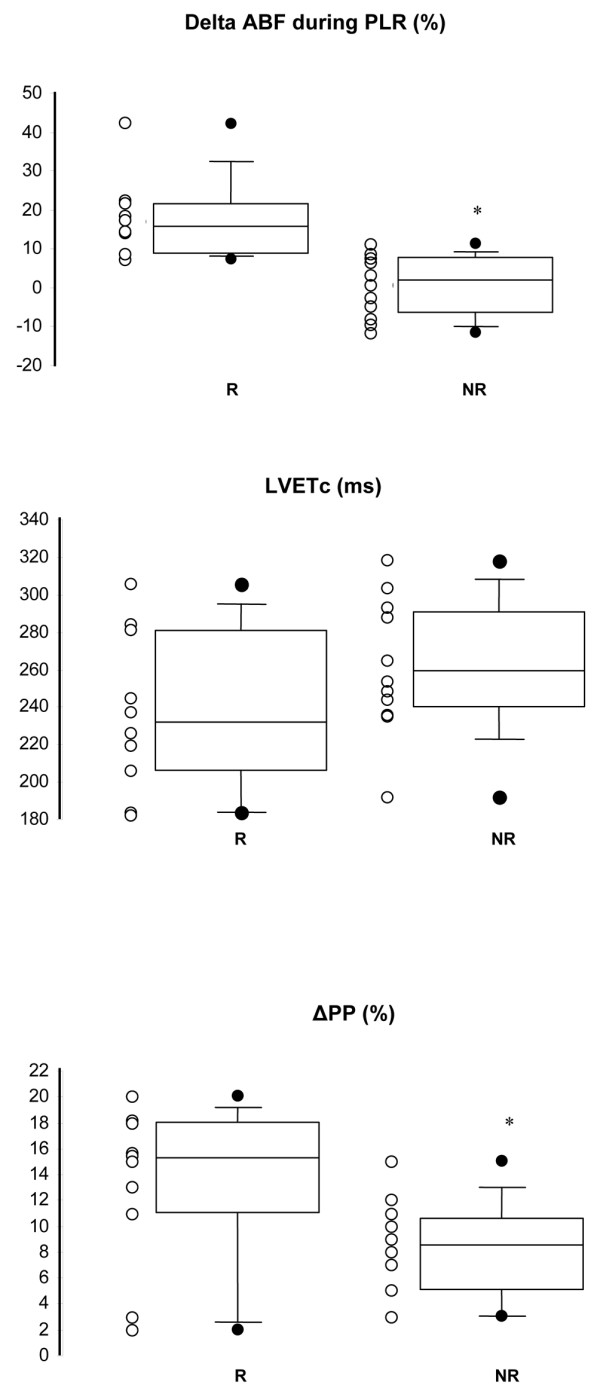
Boxplots and individual values of change in ABF, LVETc and ΔPP in responders and non-responders. Abbreviations: ABF = aortic blood flow; LVETc = left ventricular ejection time corrected for heart rate; ΔPP = respiratory variation of pulse pressure. Asterisk, p < 0.05 for responders versus non-responders.